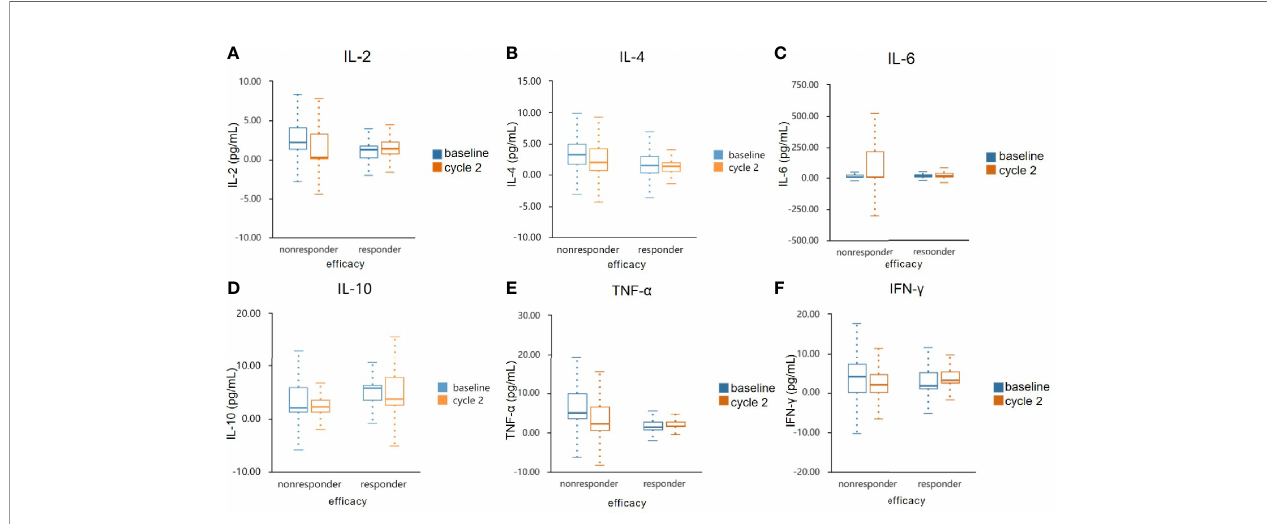
FIGURE 5 | Serum cytokine levels in the responder and non-responder groups. The serum specimens of IL-2 (A) , IL-4 (B) , IL-6 (C) , IL-10 (D) , TNF- a (E) , and IFN- g (F) were measured obtained at baseline and after two cycles treatment. IL, interleukin; TNF- a , tumour necrosis factor a ; IFN- g , interferon g